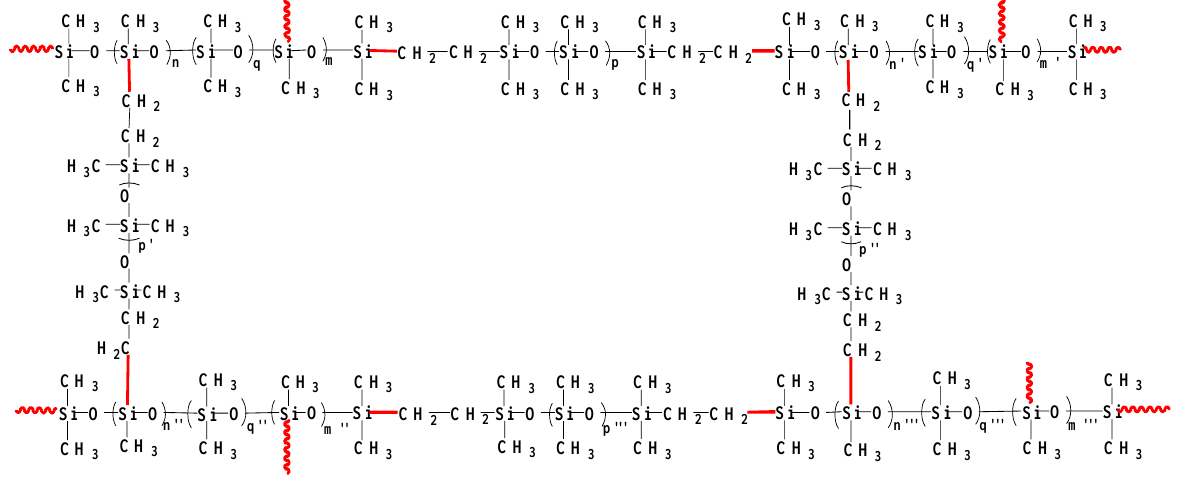
Scheme 1. The schematic cross-linking structure of SR. The red solid lines represent the bonds orig- inating from the hydrosilylation reaction of vinyl with silicon hydrogen, and the wavy lines repre- sent the chains of linear PDMS.